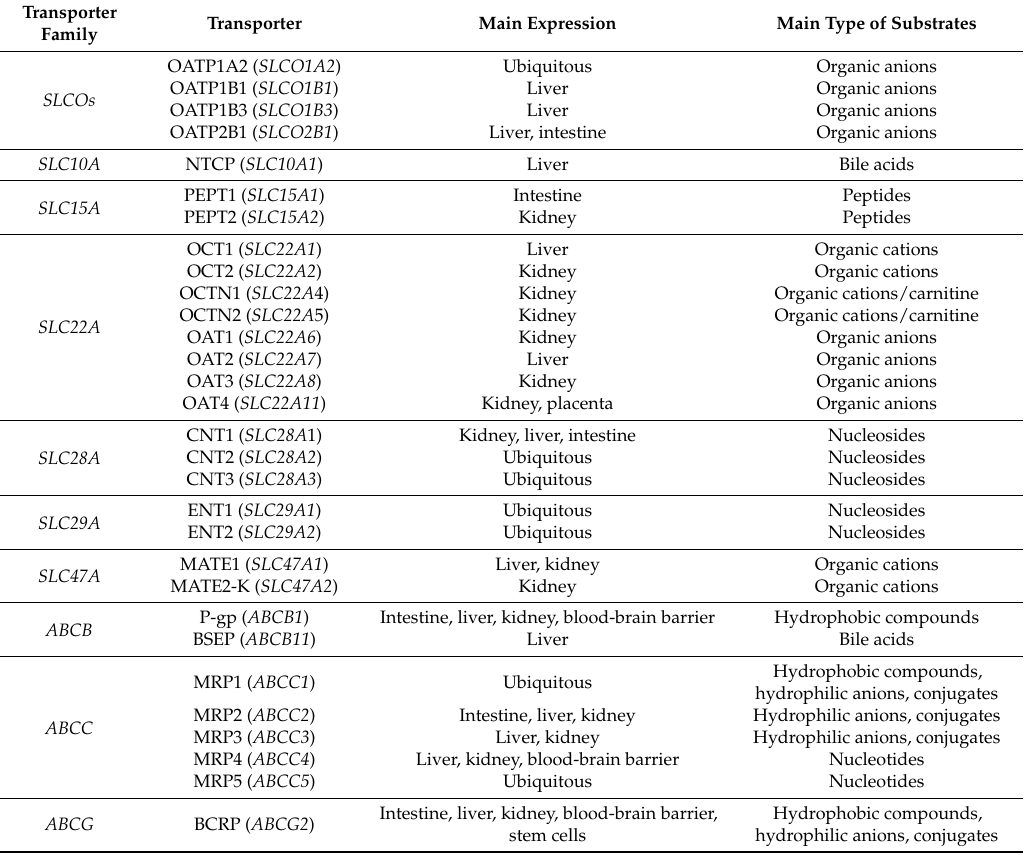
Table 1. Classification of main drug transporters. OATP: organic anion transporting polypeptide; NTCP: sodium-taurocholate co-transporting polypeptide; PEPT: peptide transporter; OCT: organic cation transporter; OCTN: organic cation transporter novel; OAT: organic anion transporter; CNT: concentrative nucleoside transporter; ENT: equilibrative nucleoside transporter; MATE: multidrug